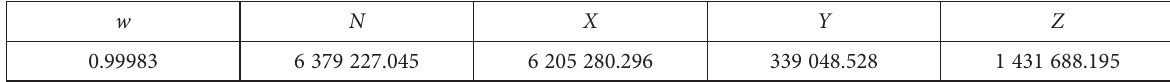
Table 6. Verification of coordinates at point no. 65